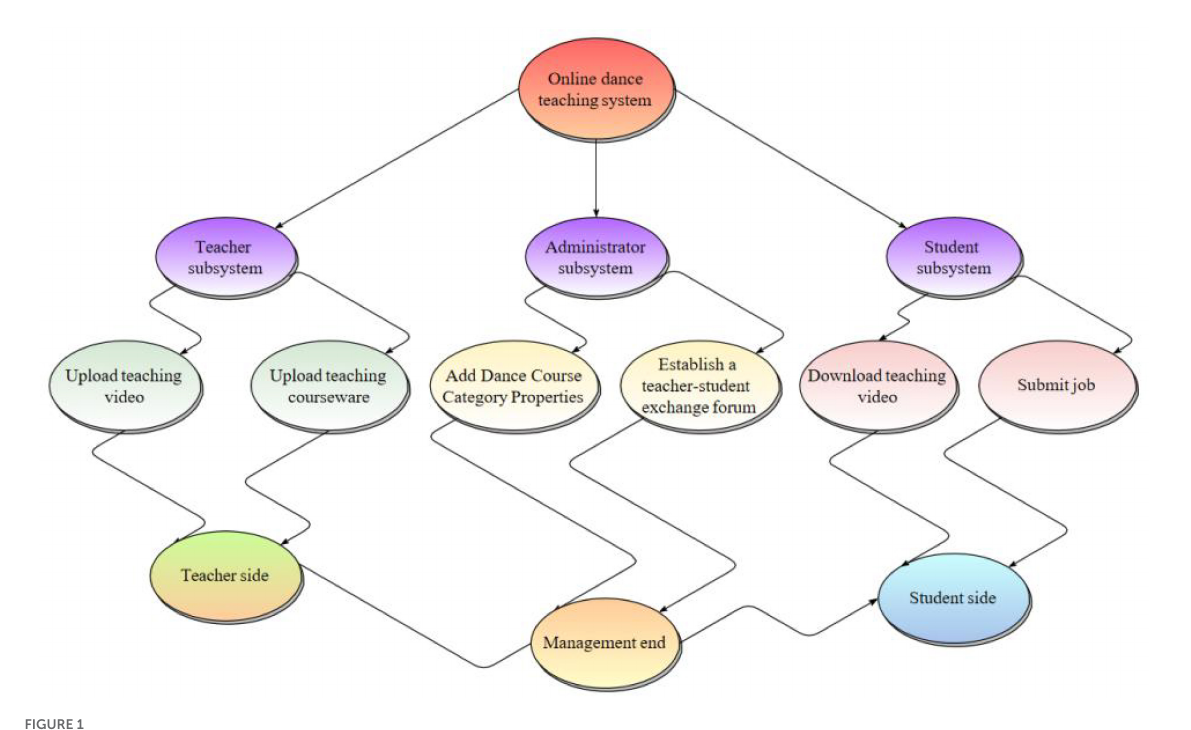
FIGURE1 Function of sub module of online dance teaching